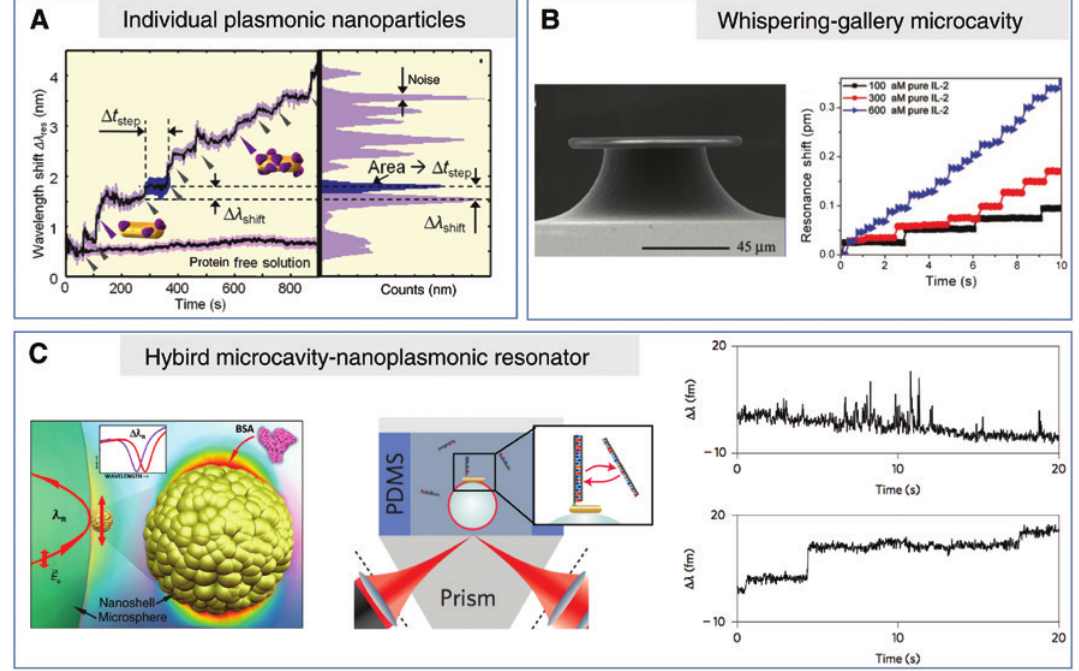
Figure 8: Detection of non-labeled single molecules. (A) The adhesion of individual fibronectin proteins shifts the plasmonic resonance peak of the gold nanorods (left). The discontinuous behavior clearly appears on the histogram of the same time traces (right). Reproduced with permission from Ref. [112]. Copyright 2012 American Chemical Society. (B) Silica micro-toroid whispering-gallery resonators (left). As individual interleukin-2 proteins bind to the surface, the resonant wavelength position discontinuously shifts. The rate of adhesion steps depends on protein concentration (right). Reproduced with permission from Ref. [113]. Copyright 2007 The American Association for the Advancement of Science. (C) Pictorial illustra- tions of a protein adhering to a gold nanosphere with irregular surface, which, in turn, is in contact with a microsphere supporting WGM (left panel, reproduced with permission from Ref. [114]. Copyright 2013 American Chemical Society) and of the coupling scheme to a microsphere supporting WGM decorated by a gold nanorod with DNA 16-base long oligomers grafted on it (central panel, reproduced with permission from Ref. [115]. Copyright 2014 Nature Publishing Group). As complementary DNA strands are placed in solution, they bind to the grafted oli- gomers either transiently or permanently depending on the conditions of the solution, producing either spikes (right upper panel) or steps (right lower panel) in the WGM